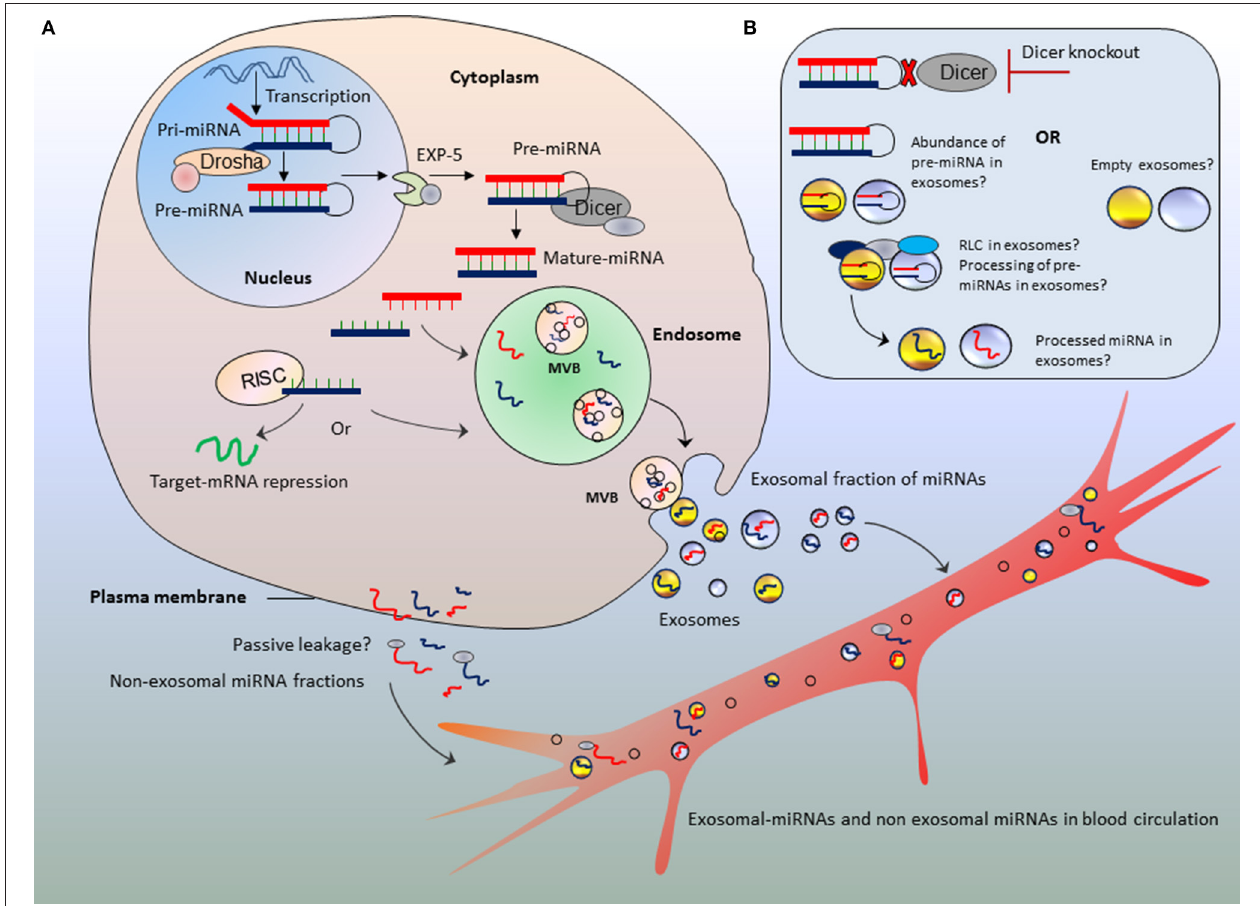
FIGURE 1 | Bridging the missing links between microRNA processing and parallel secretion into exosomes. Schematic representation of different possibilities of miRNA fates in exosomes (A,B) in parallel to abnormal procession of miRNAs or Dicer deficit. The blood circulation may acquire both exosomal-fractions and non-exosomal fractions of miRNAs. Those encapsulated in exosomes, travel to long distance organs as protected packages. (B) Potential hypothesis of abundance of un-processed pre-miRNAs or empty exosomes against the absence of Dicer